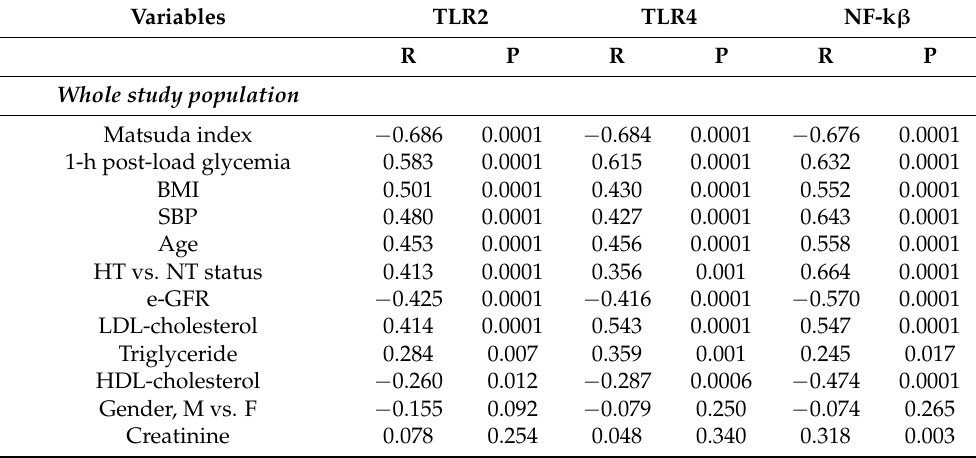
Table 3. Independent covariates related to TLRs and NF-k β expression in the whole study population, in hypertensives NGT 1-h < 155, and in NGT 1-h ≥ 155.